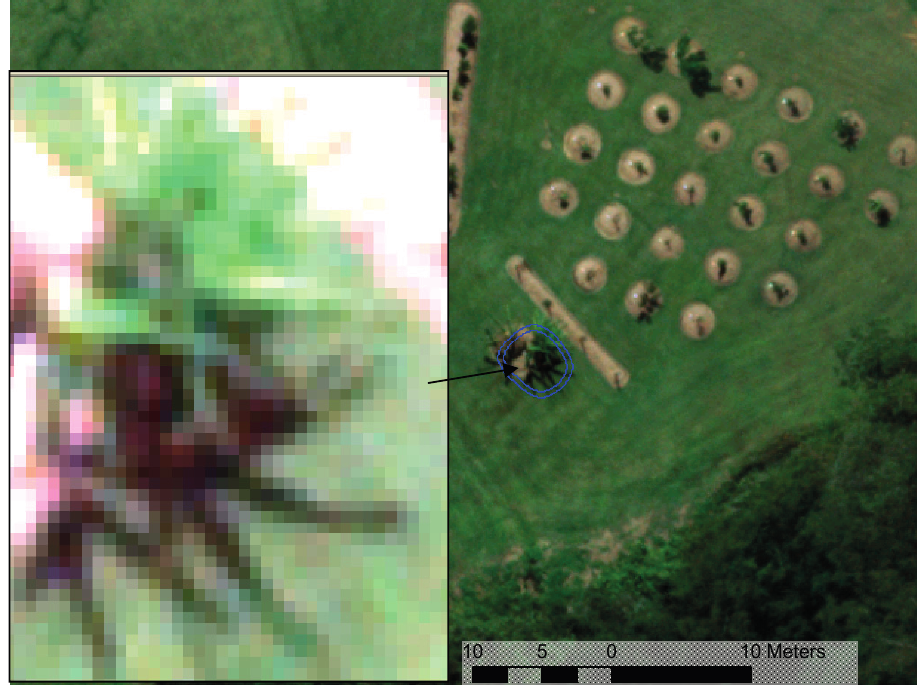
Figure 12. Banana plant with leaves creating shadows contrasting strongly against the ground. Location: 152°56 ′ 00 ″ E, 26°51 ′ 25 ″